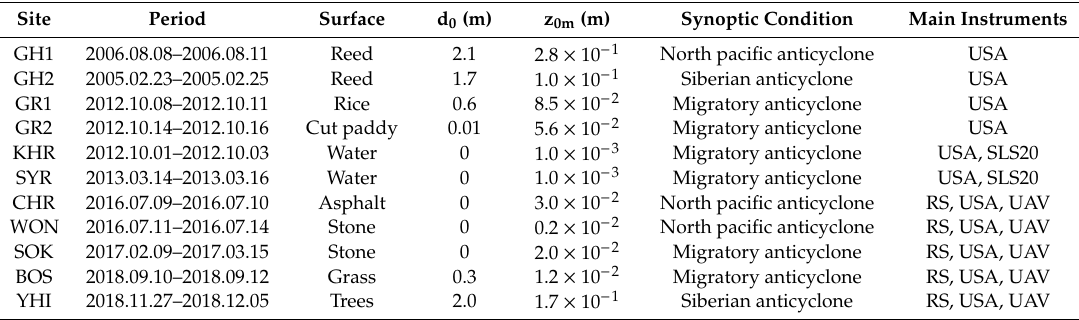
Table 1. Observation periods and characteristics for each